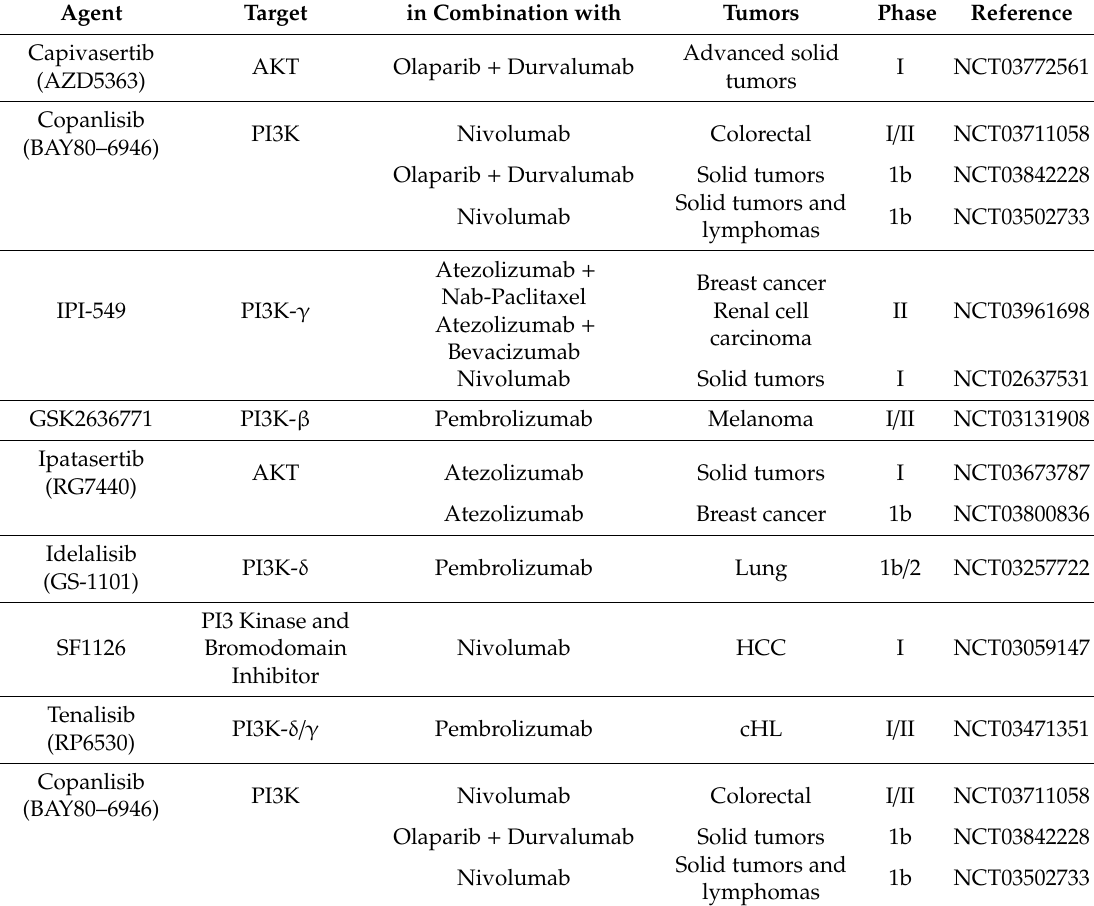
Table 2. Clinical trials with PI3K targeting agents coupled with PD-1 / PD-L1 inhibitors (http: // clinicaltrials.gov /